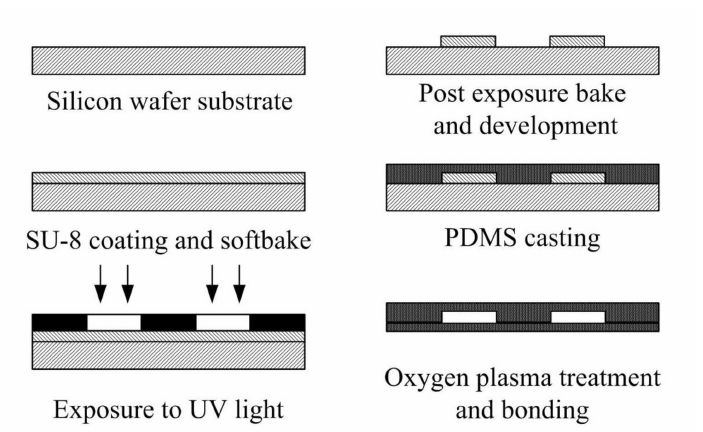
Figure 17. Fabrication processes of the planar PDMS micromixers. Major processes are photography, casting, and oxygen plasma